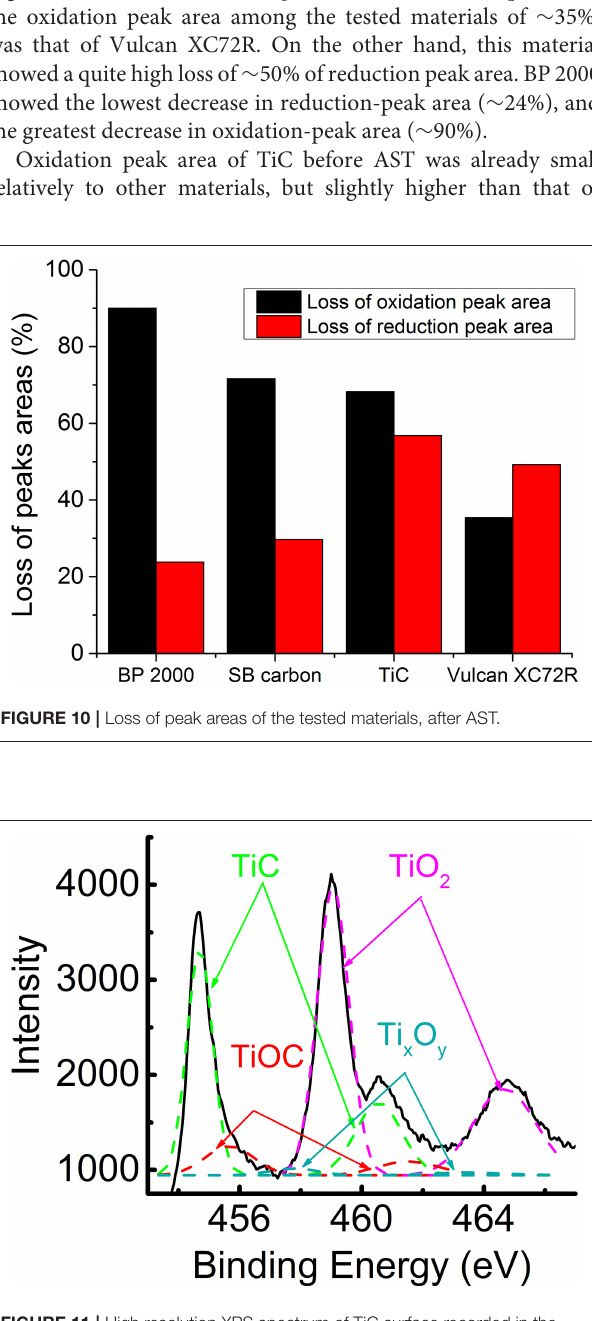
FIGURE 12 | Change of double-layer capacity of materials normalized to BET, after